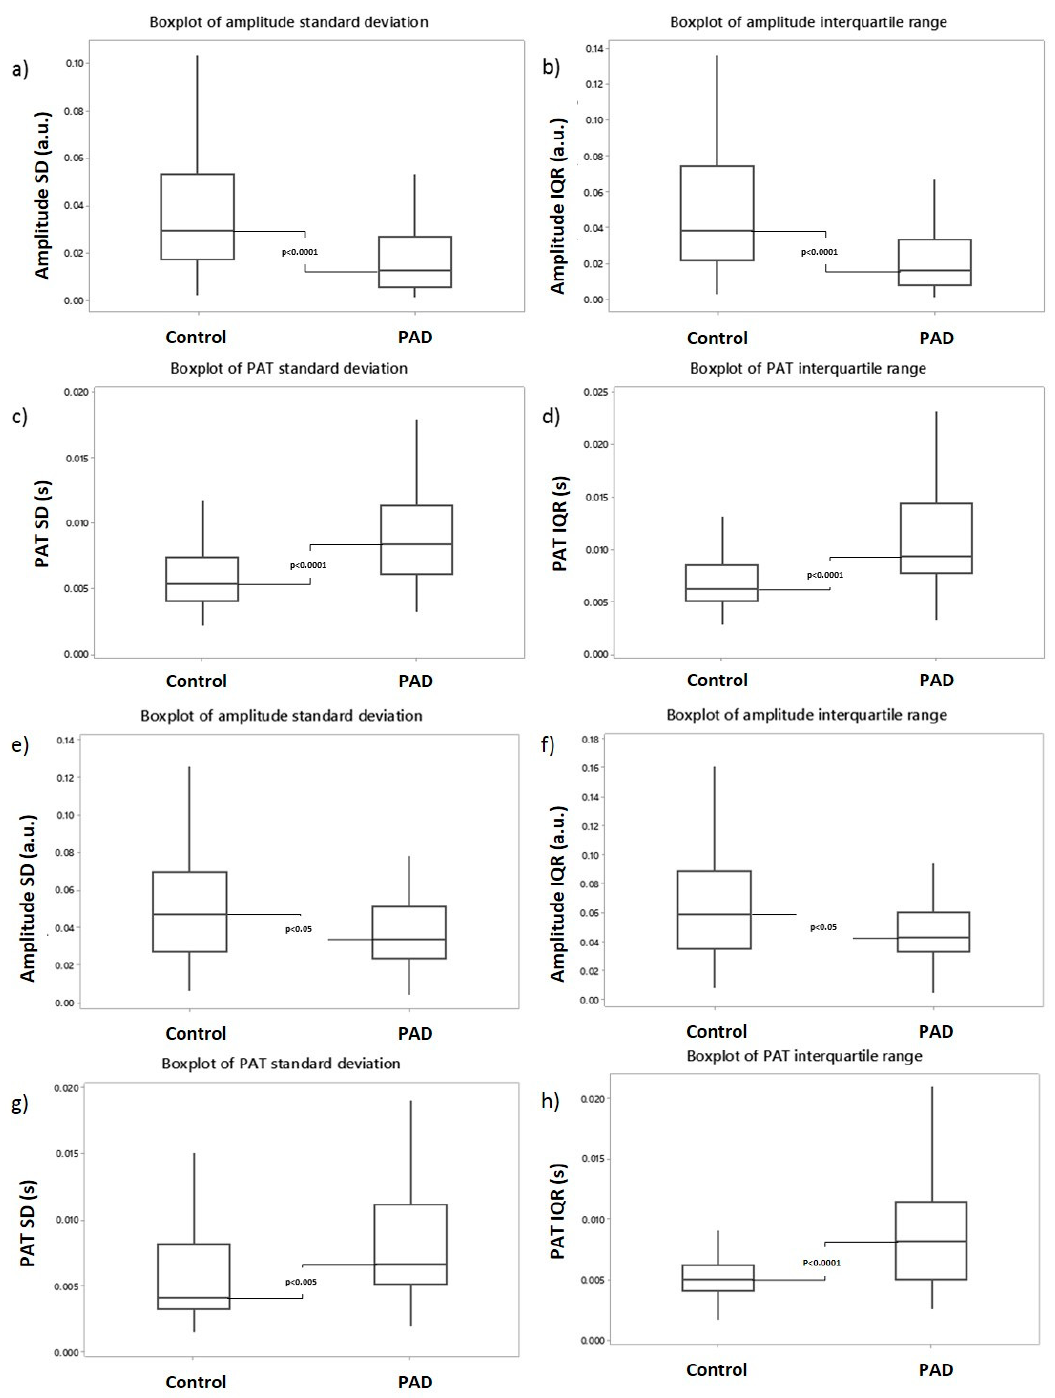
Figure 4. Boxplots of the variability for the PPG waveforms: ( a ) toe normalized amplitude variability (SD) was significantly lower in the PAD group compared to the healthy controls ( p < 0.0001); ( b ) toe normalized amplitude variability (IQR) was also significantly lower in PAD ( p < 0.0001); ( c ) toe PAT variability (SD) was significantly higher in the PAD group ( p < 0.0001); ( d ) toe PAT variability (IQR) was also significantly higher in PAD ( p < 0.0001); ( e ) finger amplitude (SD) was significantly lower in ( f ) finger amplitude (IQR) was significantly lower in PAD ( p < 0.05); ( g ) finger PAT (SD) was significantly higher in PAD group ( p < 0.005); and ( h ) finger PAT (IQR) was also significantly higher in PAD ( p < 0.0001).